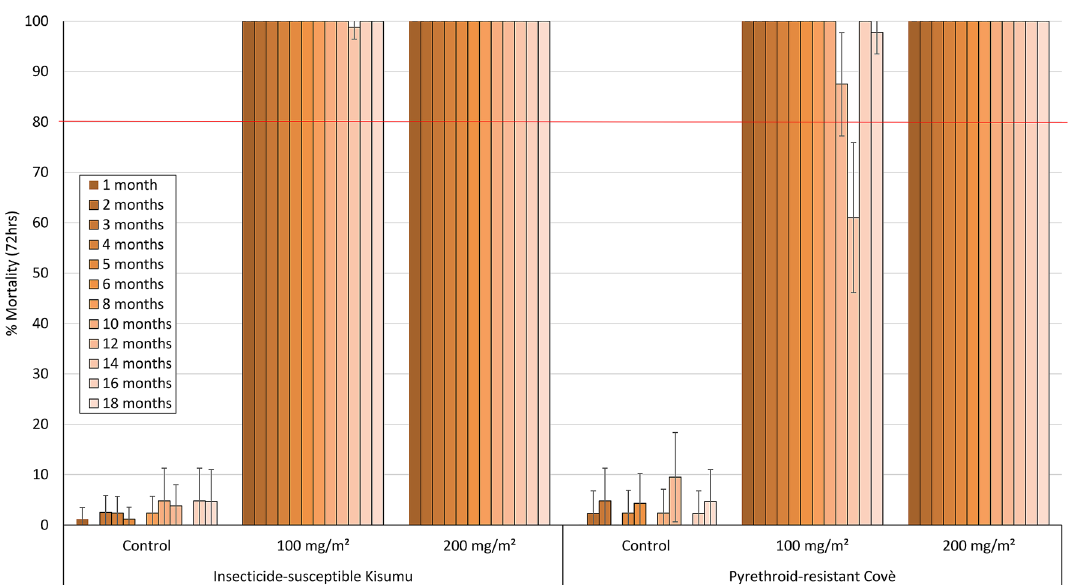
Figure 4. Monthly cone bioassays mortality of insecticide-susceptible An. gambiae ss Kisumu and pyrethroid- resistant An. gambiae sl Covè strain mosquitoes on broflanilide WP-treated mud block substrates. At each monthly time point, forty 2–5 days old female mosquitoes were exposed for 30-min in WHO cone bioassays and mortality recorded after 72 tion of 100 live and dead An. gambiae sl collected in the experimental huts during the 6-month trial, revealed that the vector was composed of 81% An. coluzzii and 19% An. gambiae ss. Exiting rates of An. gambiae sl were generally higher in broflanilide WP-treated huts (88–92%) compared to the control hut (69%; P < 0.05), but not significantly lower than in pirimiphos-methyl CS-treated huts (95%). Exiting rates with broflanilide WP did not also differ substantially between the two application rates tested and between the two substrates assessed (P > 0.05; Table 2).